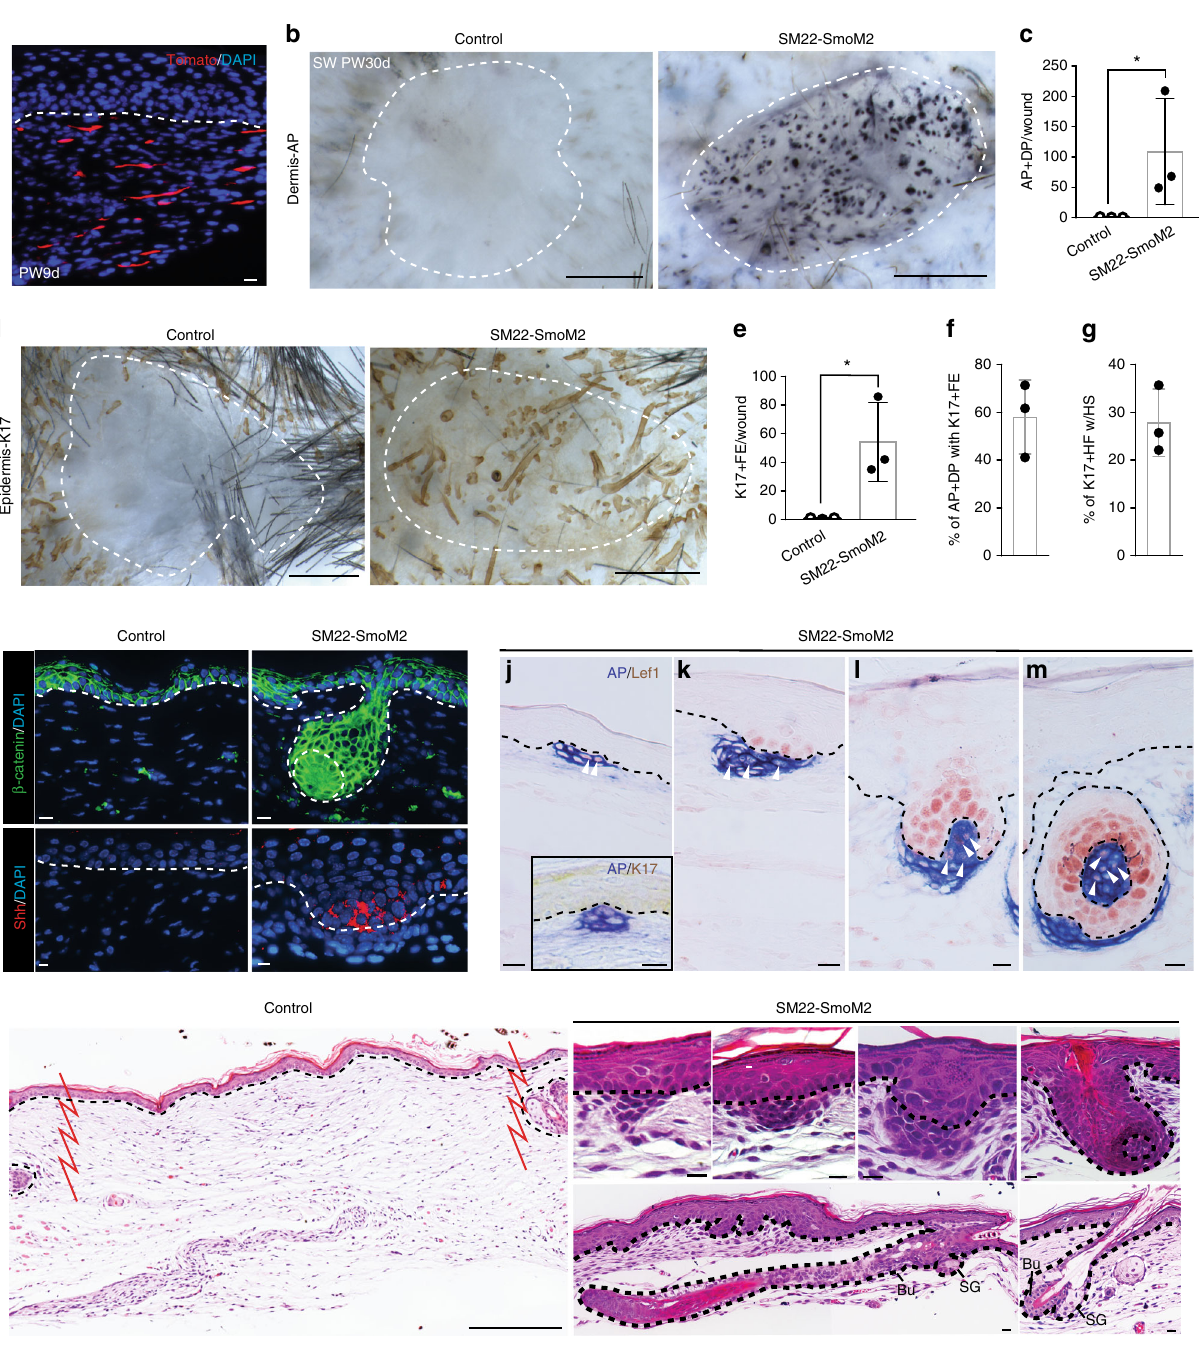
Fig. 3 Dermal Hh activation is suf fi cient to promote HFN in non-regenerative wounds. a Detection of tomato reporter on SW of SM22-rtTA; tetO-Cre; R26- Tomato mice at indicated time. b – n SM22-rtTA; tetO-Cre: R26-SmoM2 ( SM22-SmoM2 ) and littermate controls were subjected to SW and treated with doxycycline from PW1d until tissue harvest at PW30d ( n = 18 W (4 – 5 M) per condition). Whole-mount HFN assay ( b , d ) and quanti fi cations ( c , e ). Percentage of AP + DP with K17 + FE ( f ). Percentage of K17 + HF with hair shaft (HS) ( g ). Immunohistochemistry with indicated markers ( h – m ) and H&E ( n ). n : number of wounds (W) or mice (M), Data are represented as mean ± s.d., * p < 0.05; Student ’ s t -test, Dashed white circle: wound boundary, Dashed line: epidermis – dermis border, SW small wound, PW post-wound, DP dermal papilla, AP alkaline phosphatase, FE follicular epithelium, HF hair follicle, HS hair shaft, Bu bulge stem cell area, SG sebaceous gland. Scale bars represent 500 µ m ( b , d ), 100 µ m ( n (Control)), 10 µ m ( a , h – m, n